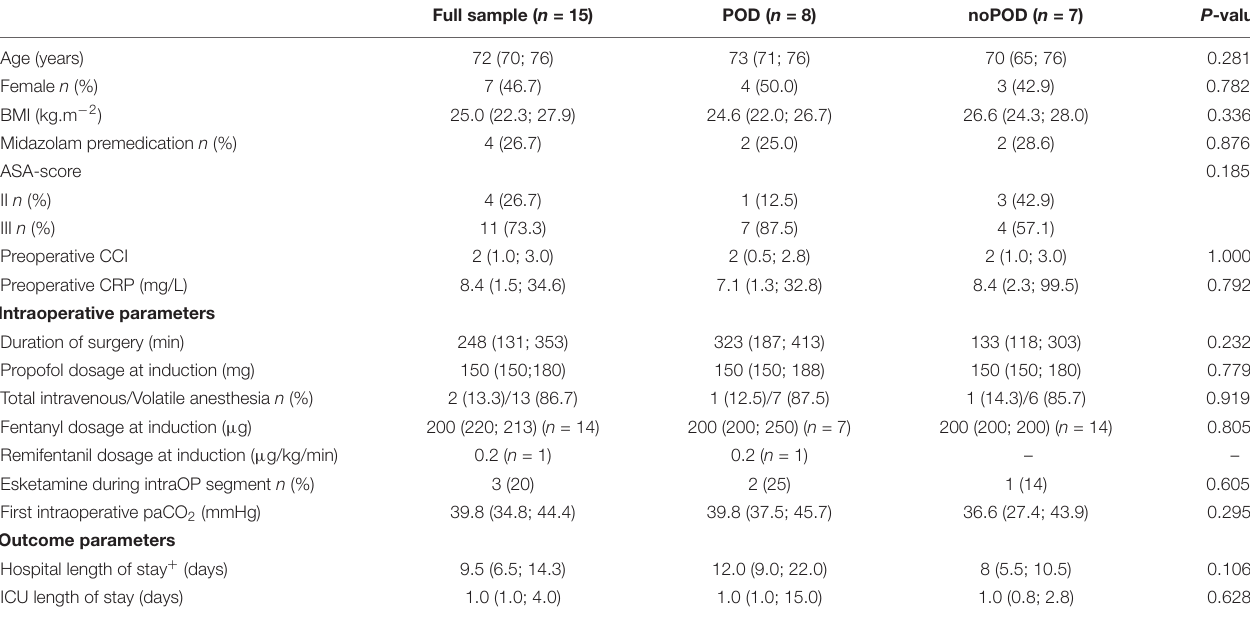
TABLE 1 | Patient characteristics for the full sample, POD, and noPOD patients.